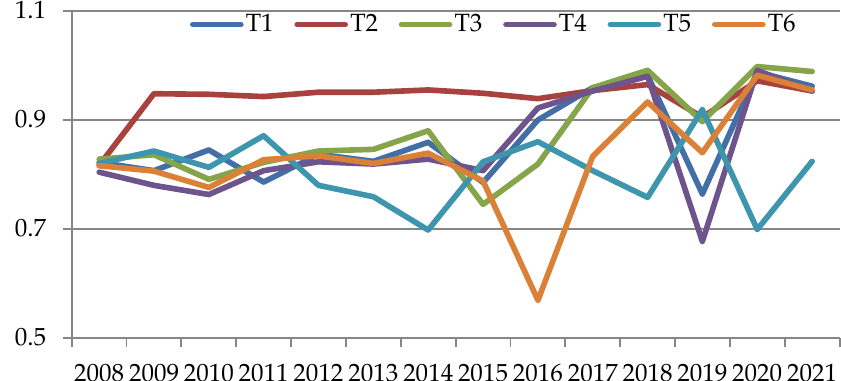
Graphs of the behavior of the performance indicator for the two enterprises are shown in Figure 13.